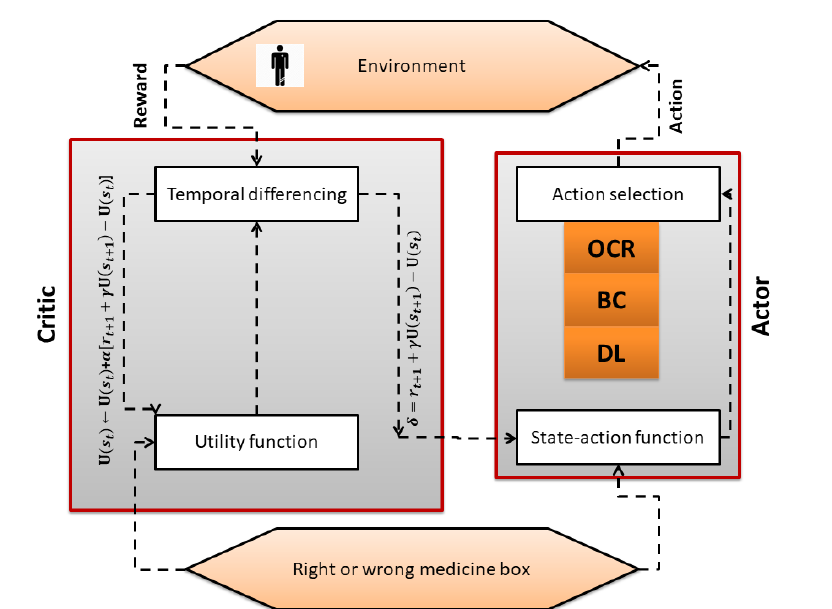
Figure 2. Working of RL